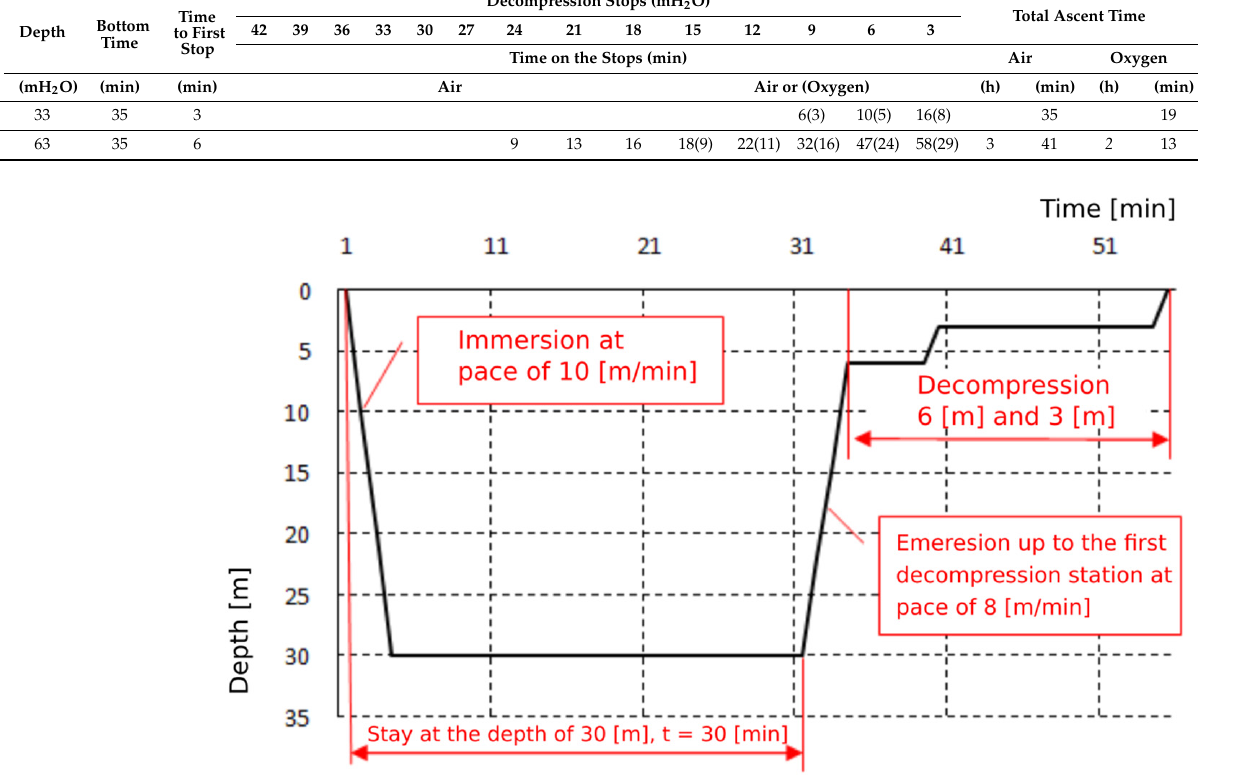
Figure 1. Pressure exposure profile 30 m/30 min.